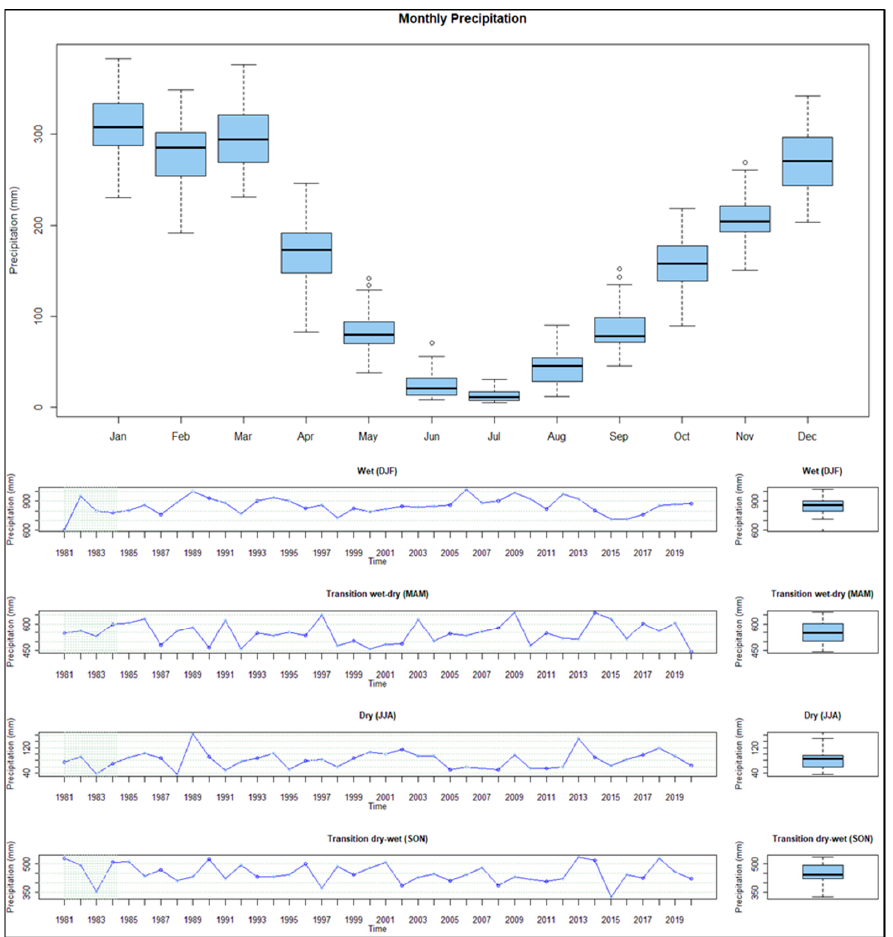
Figure 7. Monthly and seasonal distribution of rainfall in Rondônia for the years 1981 to 2020 using CHIRPS data. These are the mean values of all valid pixels of CHIRPS images.